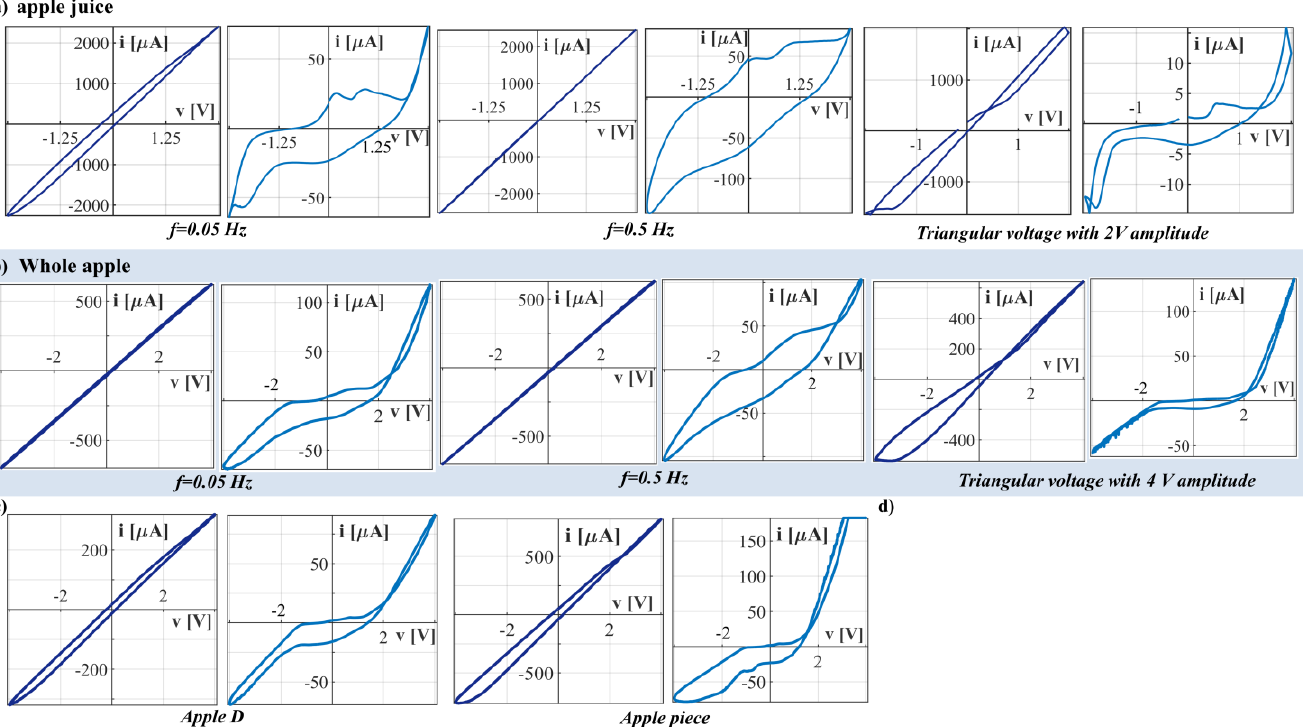
Fig. S2: Additional voltage current plots recorded from the apples, always shown for the second period of each measurement. The dark blue plots represent the results from recordings with the silver/silver chloride electrode and the light blue plots from the recordings with the stainless steel needle electrode. a ) Results from the manual extracted apple juice shown for applied sinusoidal voltage with an amplitude of 2.5 V and frequency equal to 0.05 Hz and frequency equal to 0.5 Hz and triangular voltage with 2 V amplitude and frequency of 0.005Hz. b ) Results from one whole apple (A) shown for applied sinusoidal voltage with an amplitude of 2.5 V and frequency of 0.05 Hz and 0.5 Hz and triangular voltage with an amplitude of 4 V and frequency of 0.005 Hz. At frequencies of 0.05Hz and 0.5Hz, the results from the silver/silver chloride electrode recordings are already linear, since a straight line in the voltage current plots can be observed. The needle electrode recordings are still non-linear at these frequencies. c ) Results from another whole apple (D) and from a piece of an apple shown for sinusoidal voltage with an amplitude of 4 V shown for frequency f = 0.005 Hz. The recordings on the apple pieces are quite similar to the recordings at the whole apples except that the recorded currents are higher. Saturation of the operational amplifier in the measurement channel of the needle electrode is reached and currents larger than about 175 µA could not be read.